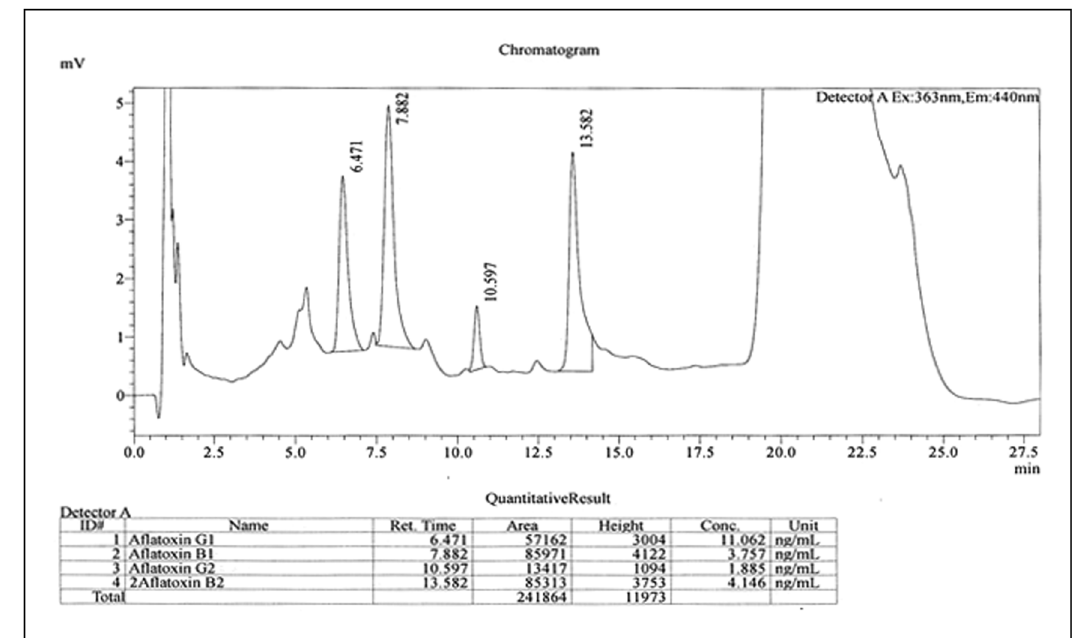
Figure 5: Chromatogram of a maize sample from Makueni County.